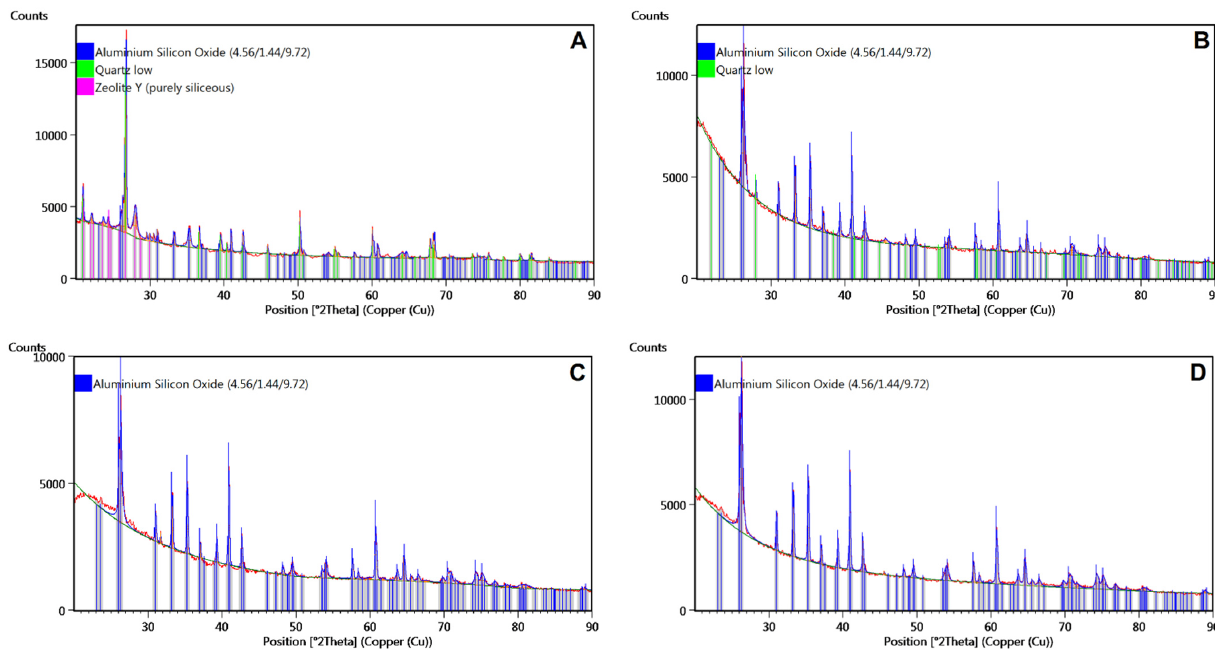
Figure 6. XRD patterns for raw CSs after purification: ( A ) F_45, ( B ) F_90, ( C ) F_150, ( D ) F_212. X-ray phase analysis (Figure 6C,D) showed that all samples contained aluminum silicon oxide Al 4.556 O 9.722 Si 1.444 with an orthorhombic crystal structure (Inorganic Crystal Structure Database: 98-015-2980). All diffraction lines from the aluminum silicon oxide are indicated by blue lines. No differences were found for the F_150 and F_212 fractions (Figure 6C,D). Only the aluminum silicon oxide phase was identified in these samples. The diffractogram of F_45 also contained diffraction lines from quartz low (ICSD:98-016-2611), indicated by green lines, and Y zeolite (pure siliceous) (ICSD:98-005-5489), indicated by pink lines (Figure 6A). For fraction F_90, an intermediate composition between the previous three was noted; in addition to the mixture of aluminum and silicon oxide, quartz was also found.